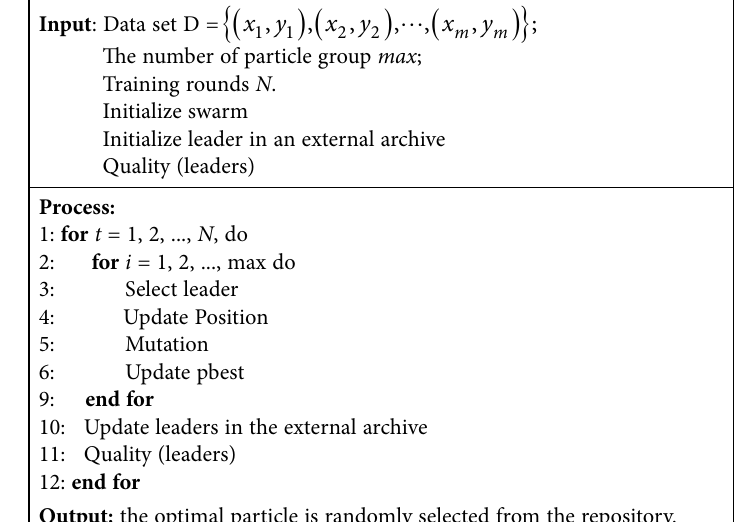
Figure 3. Pseudocode for a general MOPSO